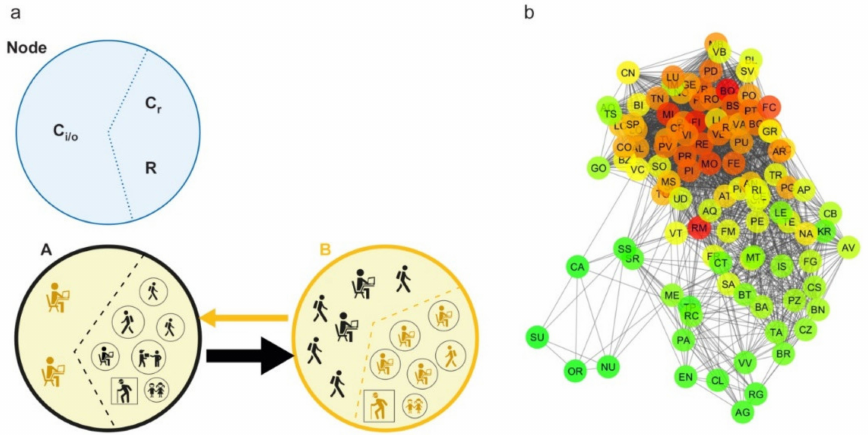
Figure 2. Commuting network structure. ( a ) All categories of commuters and noncommuters that characterize each node of the network on a typical working day are represented: commuters inside the node (C r ), incoming and outgoing commuters (C i and C o , respectively) and residents who are not commuters (R). The edge between two nodes, from a source to a destination, is represented by an arrow (direction) and its size is proportional to the number of commuters moving daily. ( b ) Graph representation of the commuting network at the province level (undirected for display purposes). The scale color from green to red is based on the node degree